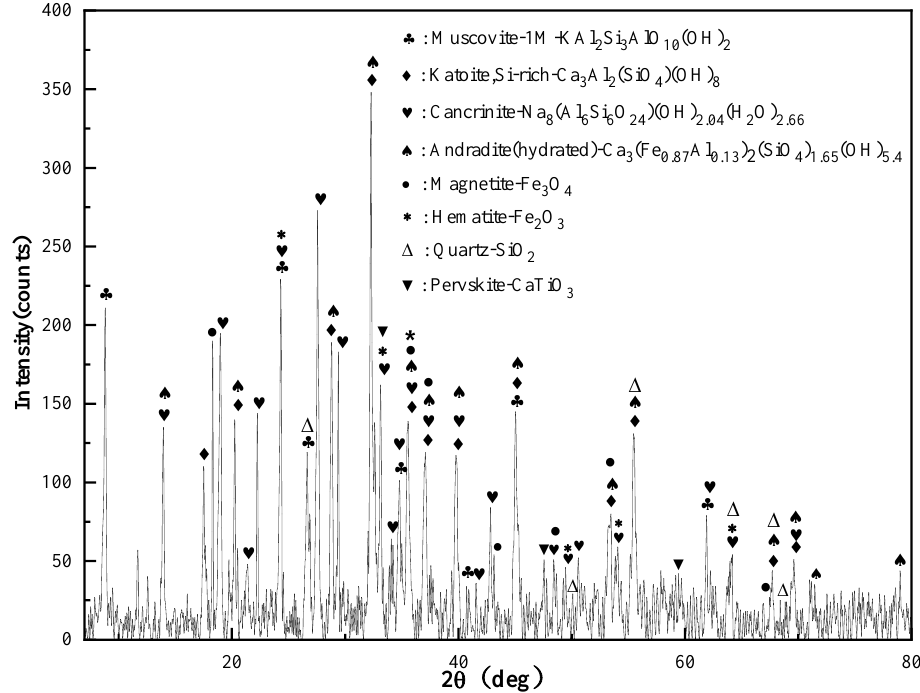
Figure 1. XRD pattern of the red-mud sample.